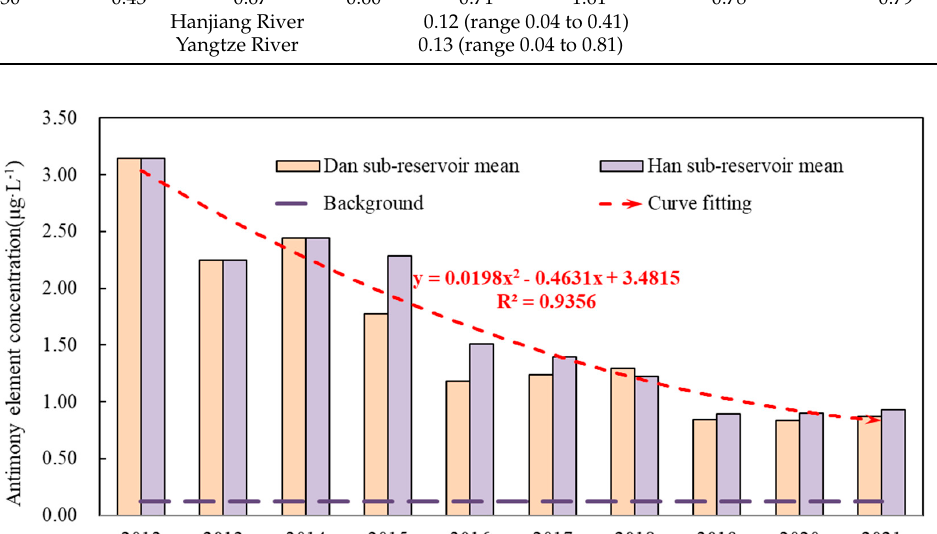
Background values